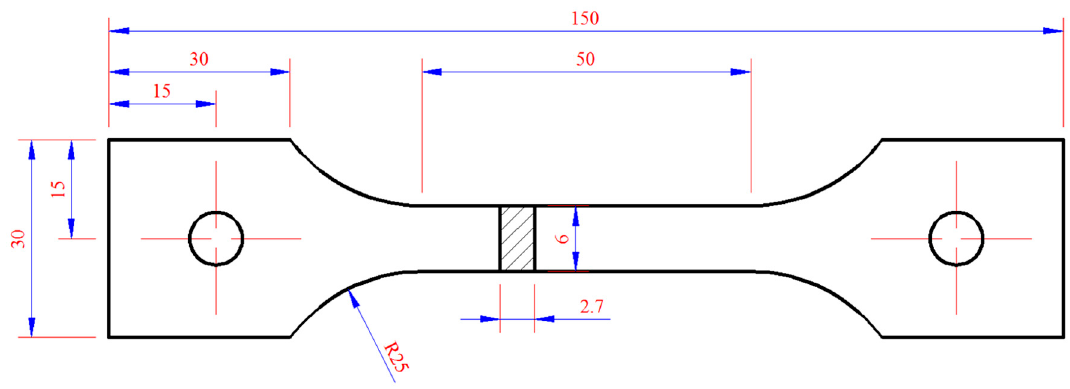
Figure 1. Schematic diagram of tensile test specimen (mm).